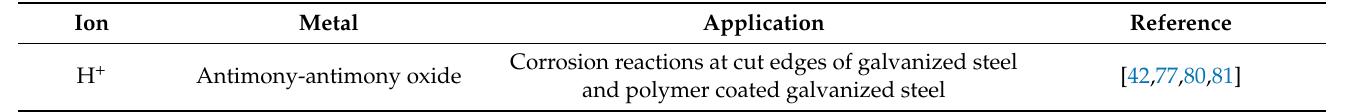
Table 3. Metallic microsensors used as potentiometric probes in SECM characterization of thin surface layers and coatings on